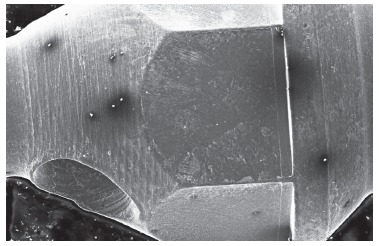
Photomicroscopy of Conexão mini-implant after 60 days of immersion in artificial saliva, evidencing the presence of whitish spots.